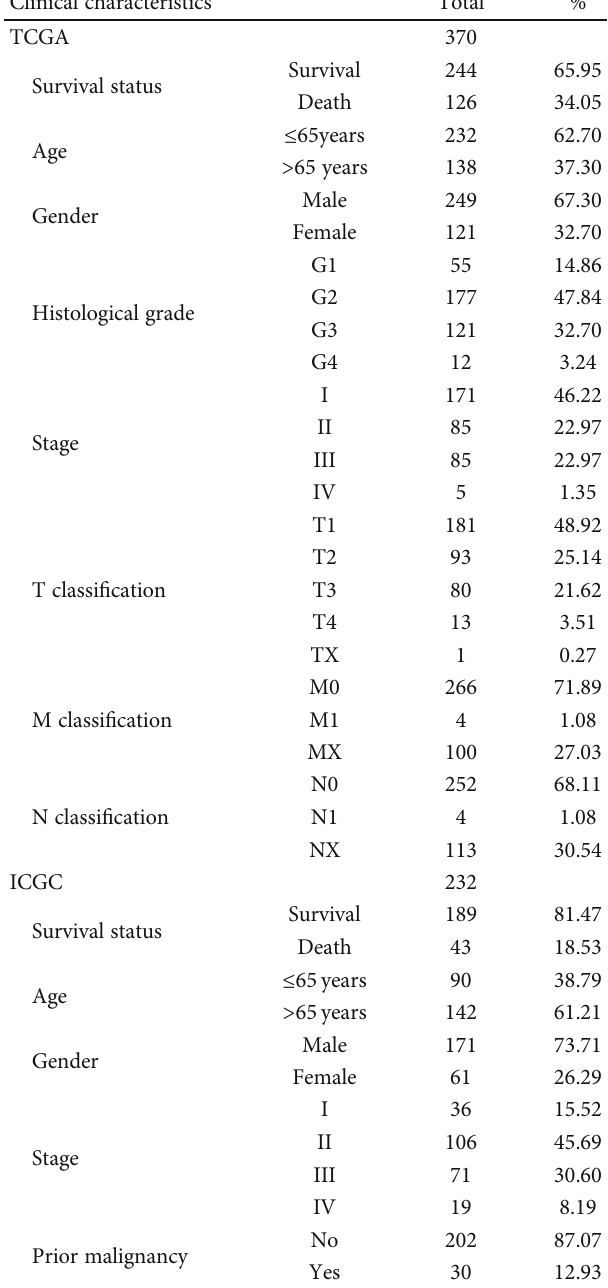
Table 1: Patients ’ information in the TCGA and ICGC cohorts. Clinical